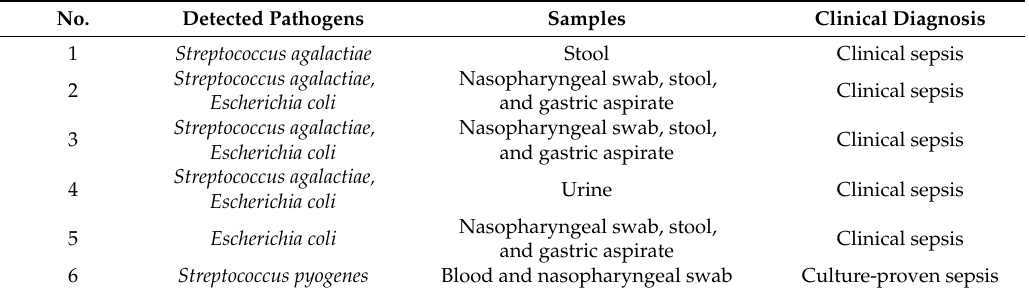
Table 4. Pathogens detected and samples used for culture among term infants in the confirmed diagnosis group.